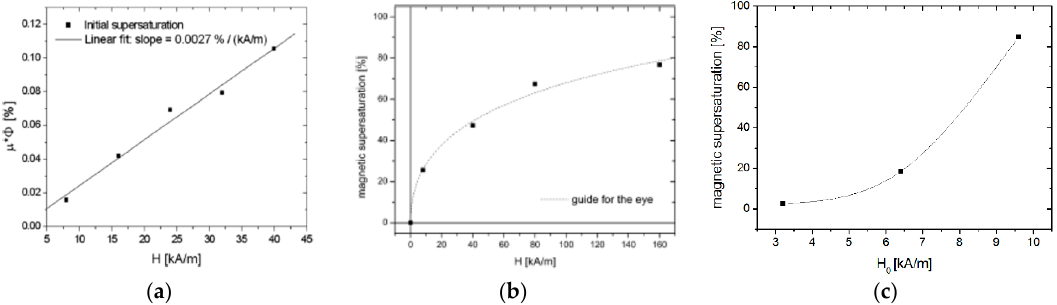
Figure 19. Magnetic field dependence of supersaturation for: ( a ) 60 nm magnetic multicore-shell nanoparticles (MMCS) in DC field. Reprinted with permission from Reference [35], ( b ) 100 nm MMCS in DC field. Reprinted with permission from Reference [63], and ( c ) 250 nm MMCS in AC field [159].